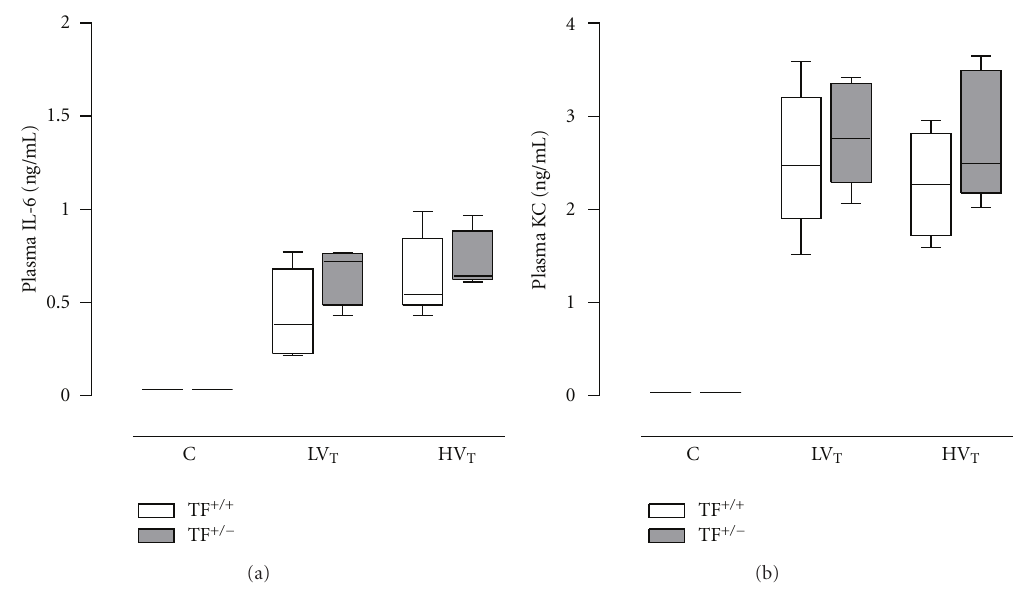
Figure 7: Systemic levels of interleukin (IL)-6 and keratinocyte-derived chemokine (KC) in plasma after 5 hours in control mice (C) and mice ventilated for 5 hours with lower tidal volumes (L V T ) or higher VT (H V T ). Each group consisted of heterozygote TF knock-out mice (TF + / − ) and their wild-type littermates (TF + / + ). Data represent medians and interquartile range of six mice. Di ff erences between TF + / − and TF + / + are not statistically